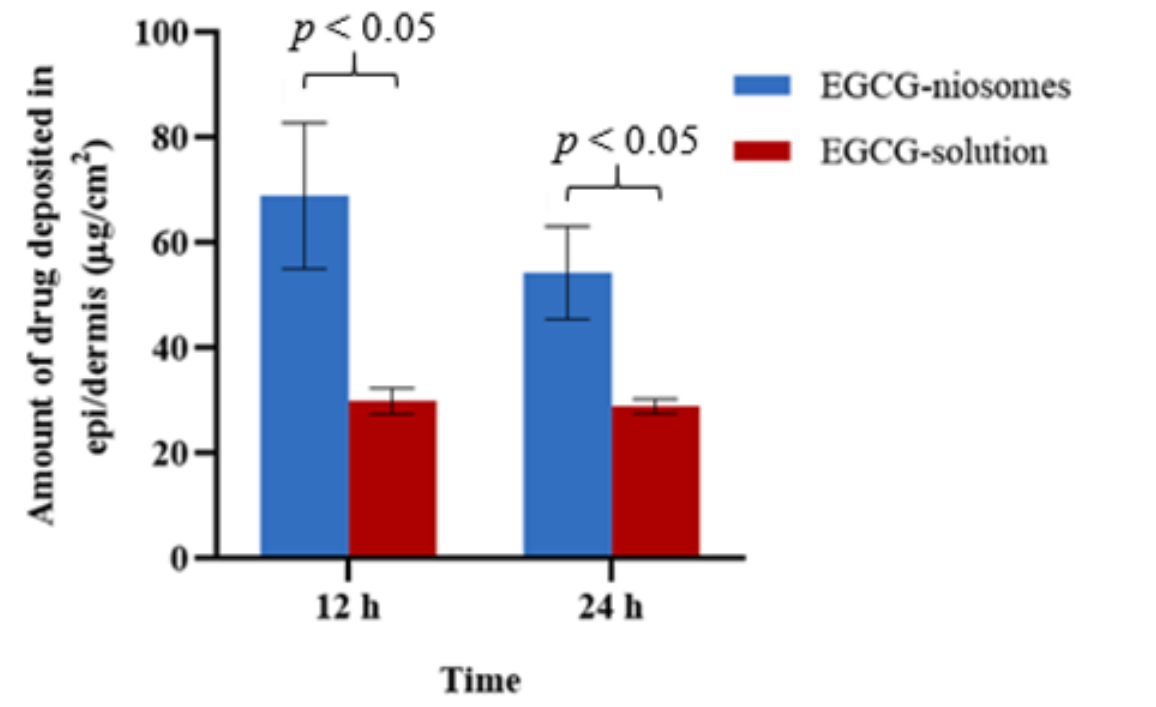
Figure 5. The amount of drug deposited in the human skin layers from EGCG-niosomes and EGCG- solution (mean ± SD, n = 3).